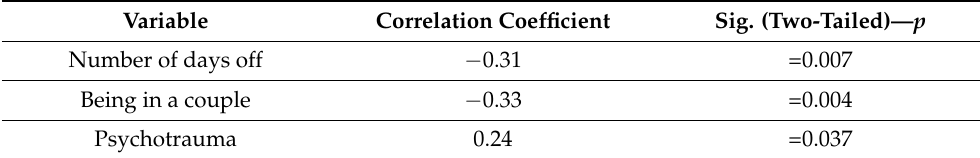
Table 2. Correlation of different variables with burnout syndrome.